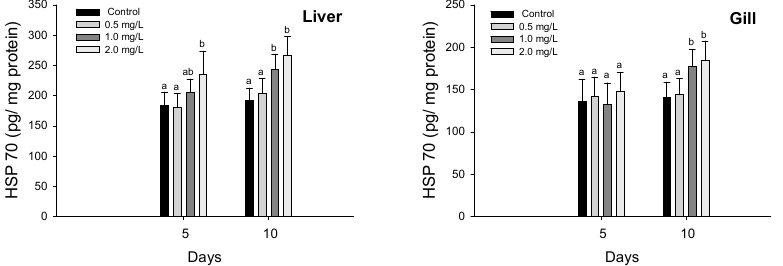
Figure 4. HSP 70 of flatfish, Paralichthys olivaceus, exposed to the different concentrations of water- borne chromium for 10 days. Values with different superscripts are significantly different in 5 and 10 days ( p < 0.05) as determined by Tukey’s multiple range test.